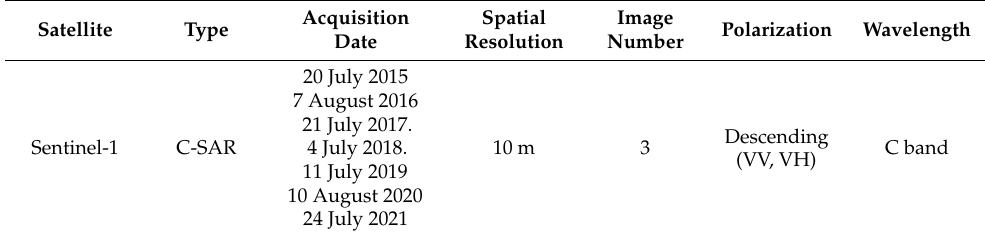
Table 1. Main specification of satellite imagery used in the